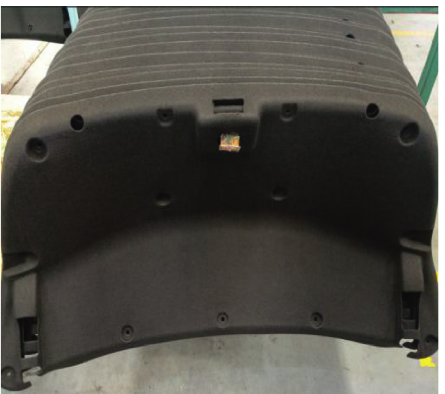
Figure 14: Cooling.